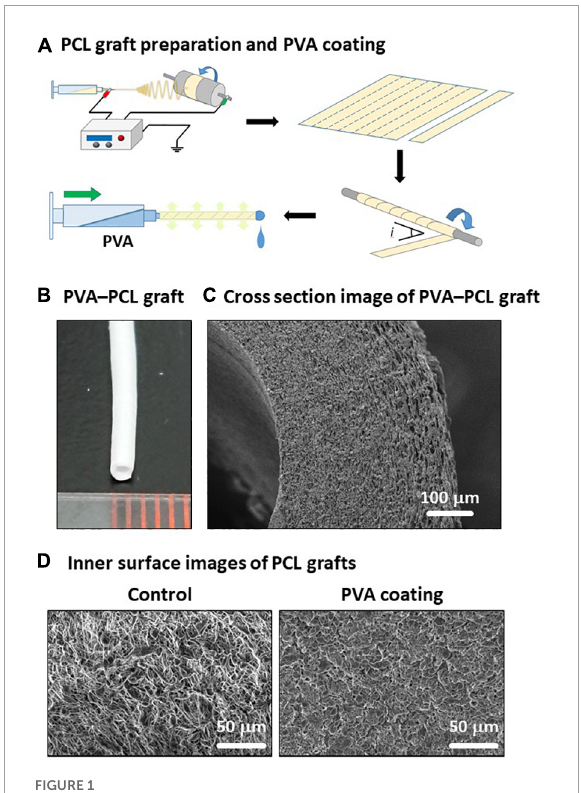
FIGURE1 Fabrication of PVA–PCL graft with 1 mm inner diameter. (A) Scheme of PCL graft preparation and PVA coating. (B) PVA–PCL graft. (C) Cross-section of PVA–PCL graft by SEM imaging. (D) Comparison of the luminal surface structure before and after PVA